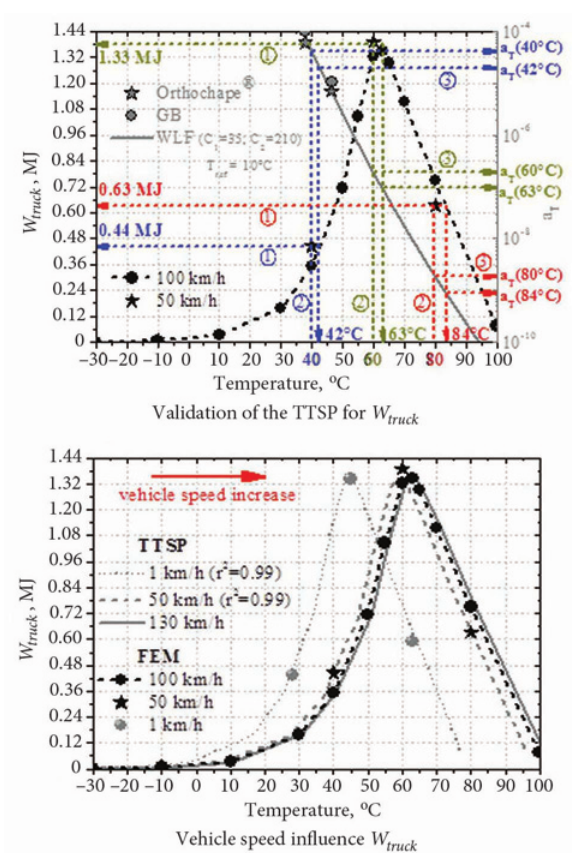
fig. 8. Validation of the TTSP and analysis of vehicle speed influence for dissipated